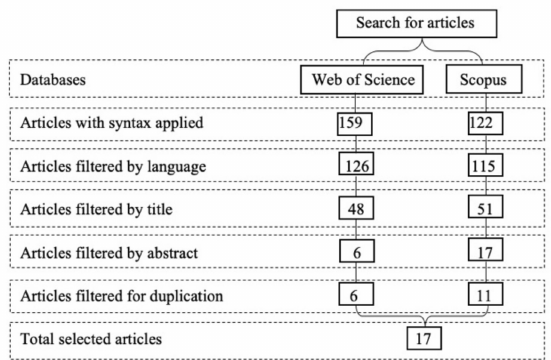
Figure 1. Methodological outline of the PRISMA-type systematic review